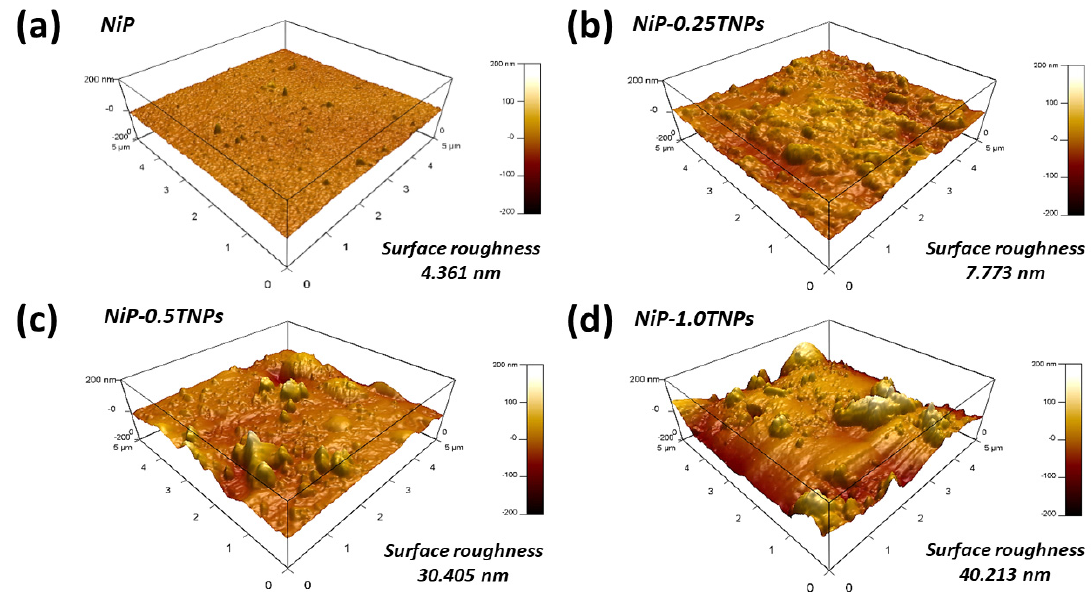
Figure 3. The 3D Surface topographic images for NiP ( a ), NiP-0.25TNPs ( b ), NiP-0.50TNPs ( c ), and NiP-1.0TNPs ( d ) nanocomposite coatings. Table 2. Comparison of roughness parameters for NiP, NiP-0.25TNPs, NiP-0.5TNPs and NiP-1.0TNPs nanocomposite